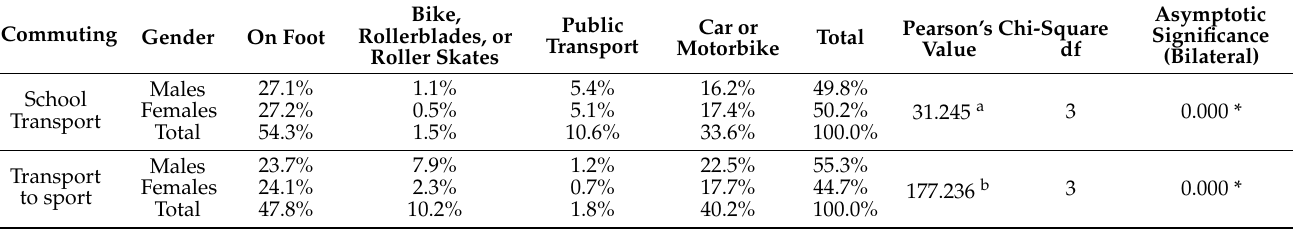
Table 2. Distribution of frequencies by sex and chi-square